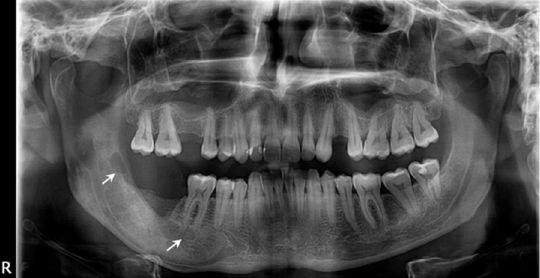
Figure 7. The initial aspect of two unilocular radiolucencies: one at the anterior part of the ascendent ramus (arrow), and the anterior one in the apical root of tooth #46 (arrow), without clear delimita-